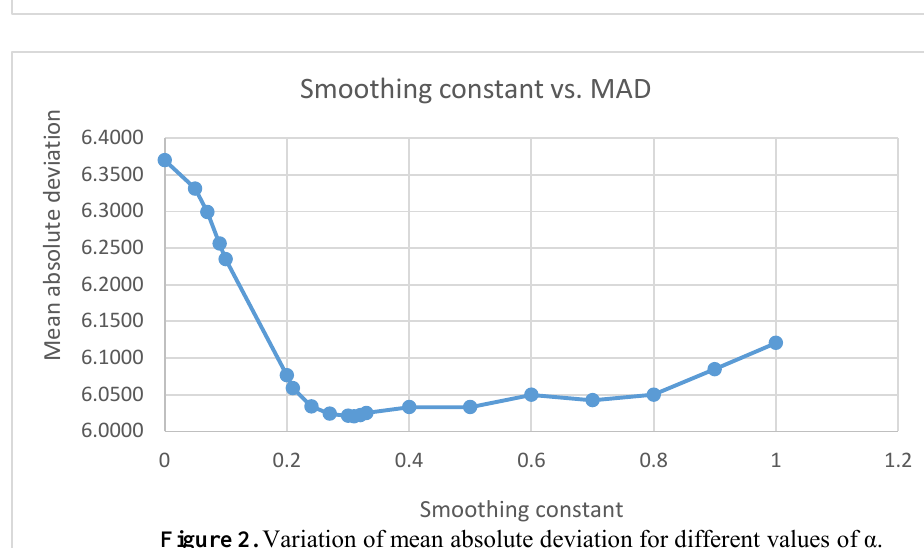
Figure 1. Variation of mean square error for different values of α.